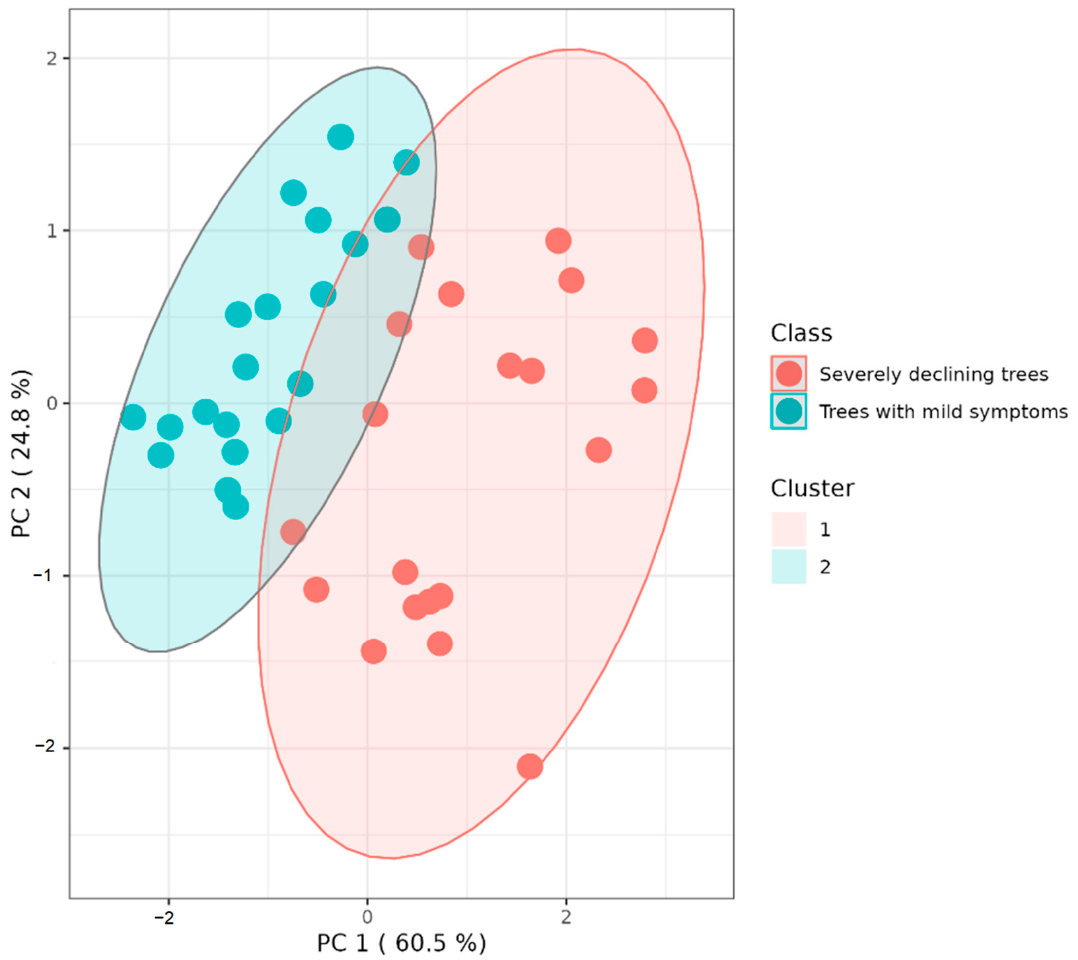
Figure 7. K-means cluster analysis of standardized values of three variables (proportion of beech roots infected by Phytophtora × cambivora , foliage transparency of beech trees, and inoculum density of P. × cambivora in rhizosphere soil of beech trees) grouping the samples into two clusters: trees with mild symptoms (blue dots) and severely declining trees (red dots).